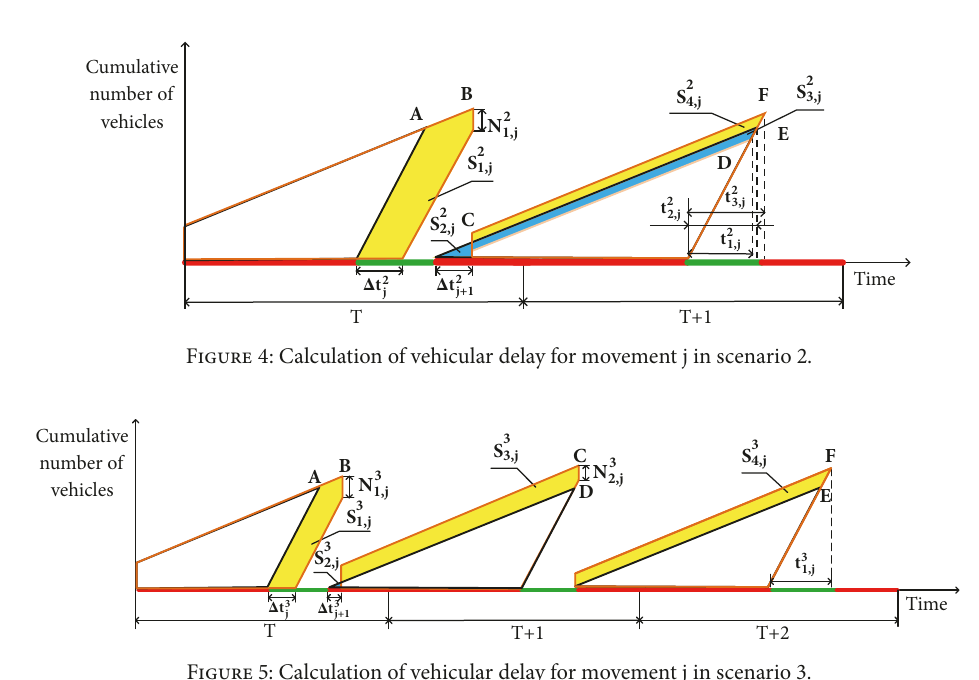
Figure 5: Calculation of vehicular delay for movement j in scenario